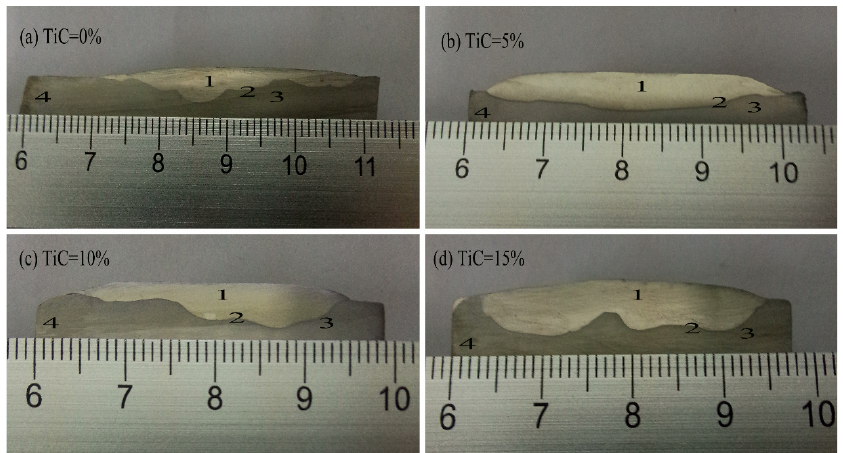
Figure 3. The macroscopic morphology of cross-section of with different TiC content 1: Cladding 2: Fusion line 3: Heat affect zone 4: Based metal ( a ) TiC = 0%, ( b ) TiC = 5%, ( c ) TiC = 10% and ( d ) TiC =